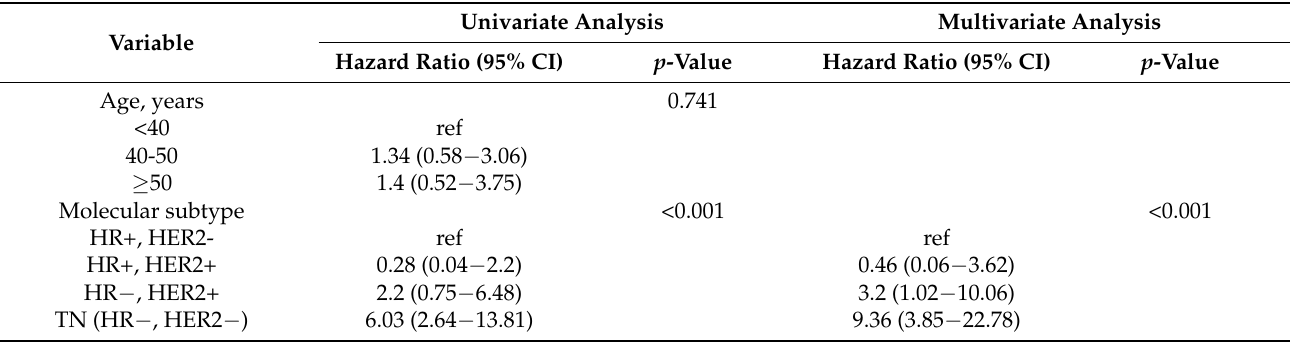
Figure 5. Genetic alterations in NGF-TrkA/p75NTR axis genes and their association with OS and RFS in BC patients (cBioPor- tal). ( A ) OncoPrint showed genetic alterations of NGF receptor pathway genes from METABRIC samples. ( B ) Kaplan–Meier curves comparing survivals in BC cases with or without genetic alterations in NGF pathway genes. Table 4. Cox regression analysis for overall survival